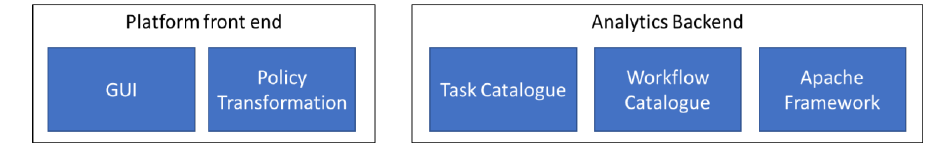
Figure 3. Platform Components.